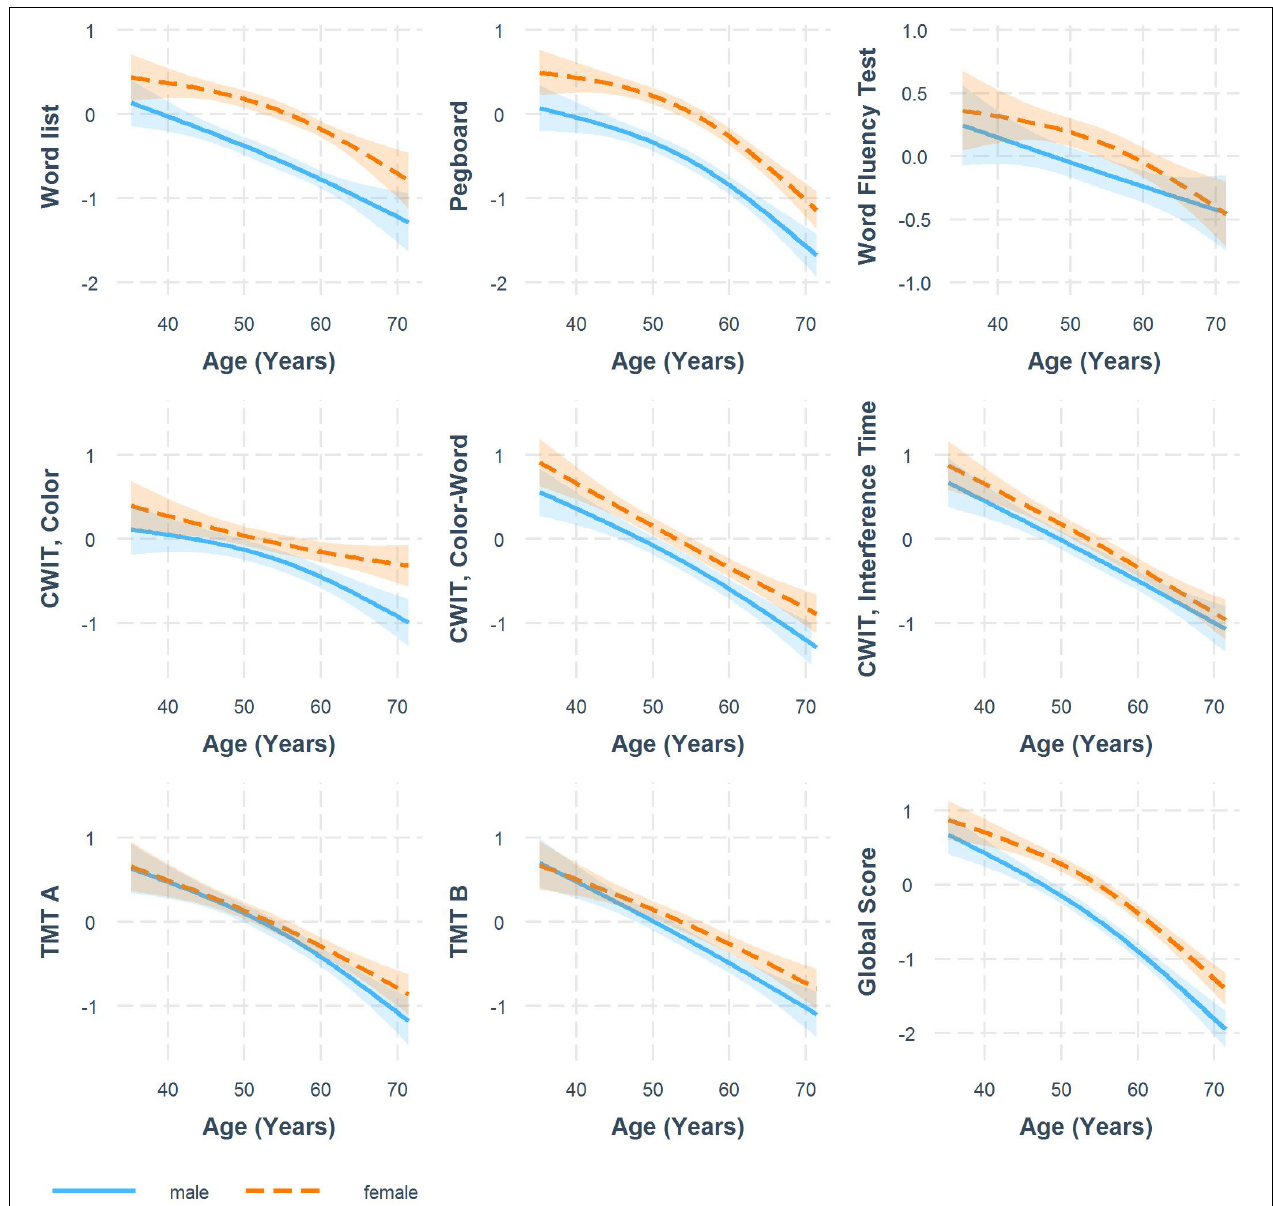
FIGURE 1 | Comparison of sex-specific trajectories for standardized neuropsychological test results shown at first study participation with 95% confidence intervals (CI). Results from weighted linear mixed